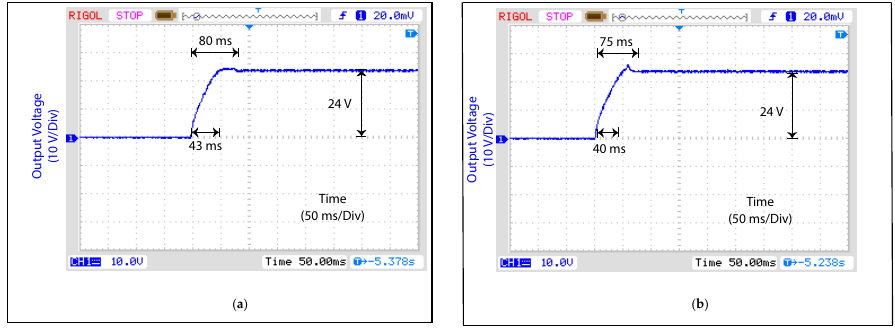
Figure 7. Step response of the system. ( a ) conventional current-mode controller; ( b ) fixed frequency Double Integral Sliding Mode Control (DI-SMC).